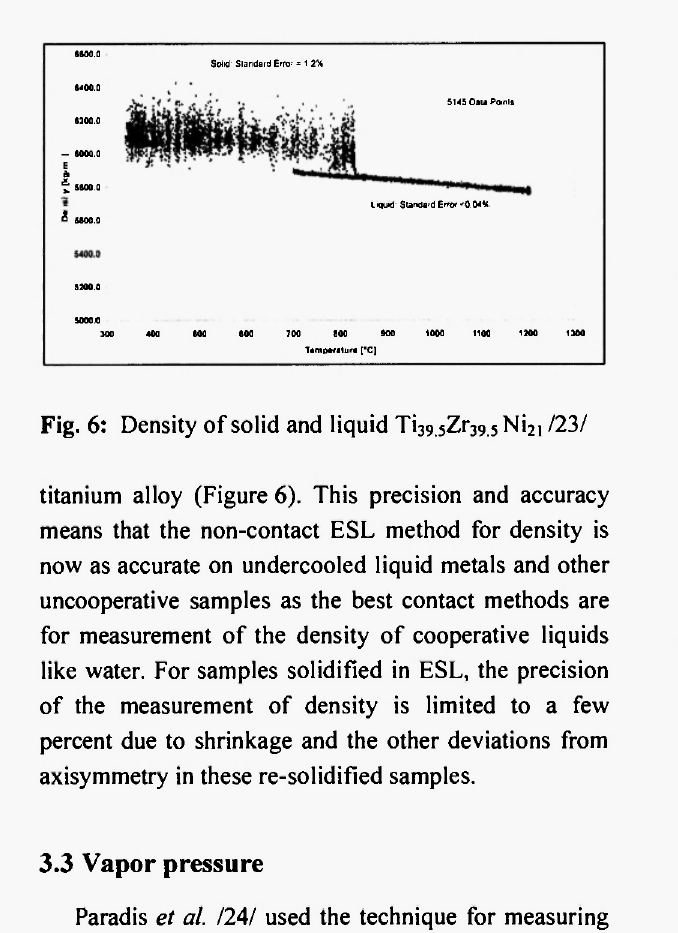
Fig. 7: Temperature-time profile of a Zr 4 |.2Ti|3 8 Cul 2 5Ni|ooBe22.5 sample alloy, which is undercooled below the liquidus temperature Tliq, and eutectic temperature Teut. The undercooled liquid freezes to a glass in the glass transition region (hatched). A small exothermic effect is observed at about 750 Κ (arrow). 125/